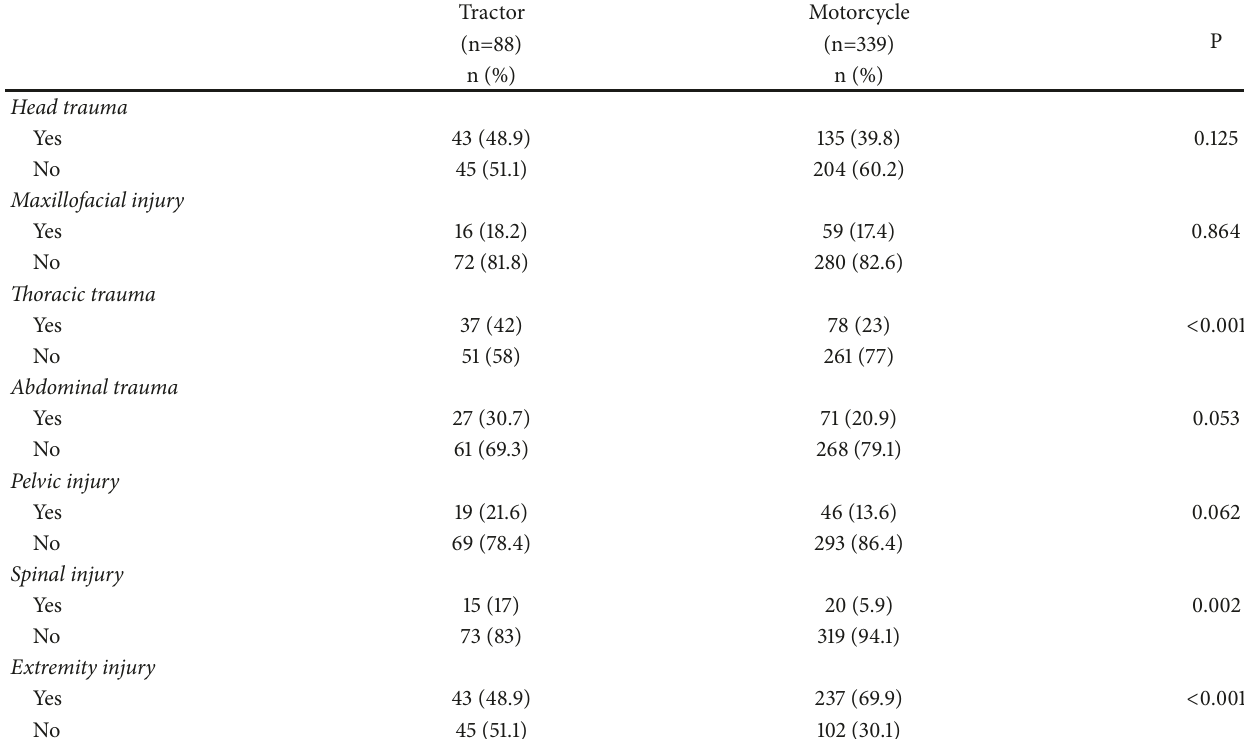
Table 2: Types of traumas in the study